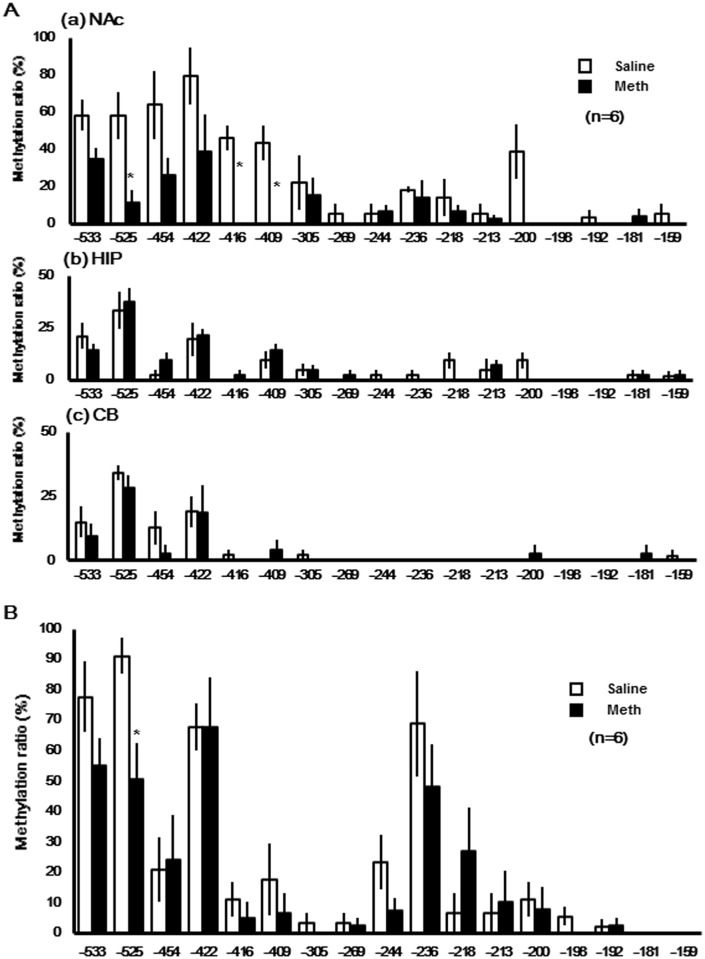
The methylation profiles of Shati/Nat8l DNA from mouse brain (A) and cardiac blood (B).The promoter region of Shati/Nat8 was analyzed in DNA collected from (a) nucleus accumbens (NAc), (b) hippocampus (HIP), (c) cerebellum (CB) and (B) cardiac blood (BLD) of mice. The methylation ratios of each CpG unit and the average of the region are represented. Saline and Meth groups are indicated by white and black bars, respectively. Data are plotted as the mean ± SEM. n = 6 mice. Significance is set at *p < 0.05.